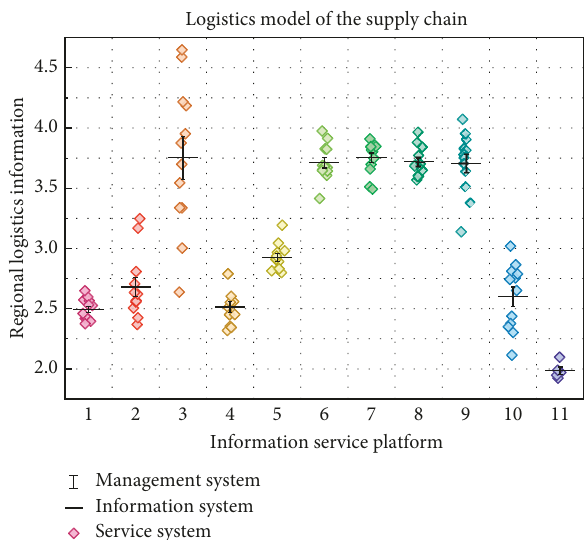
Figure 2: Dotted line diagram of regional logistics information with information service platform in three important logistics information service